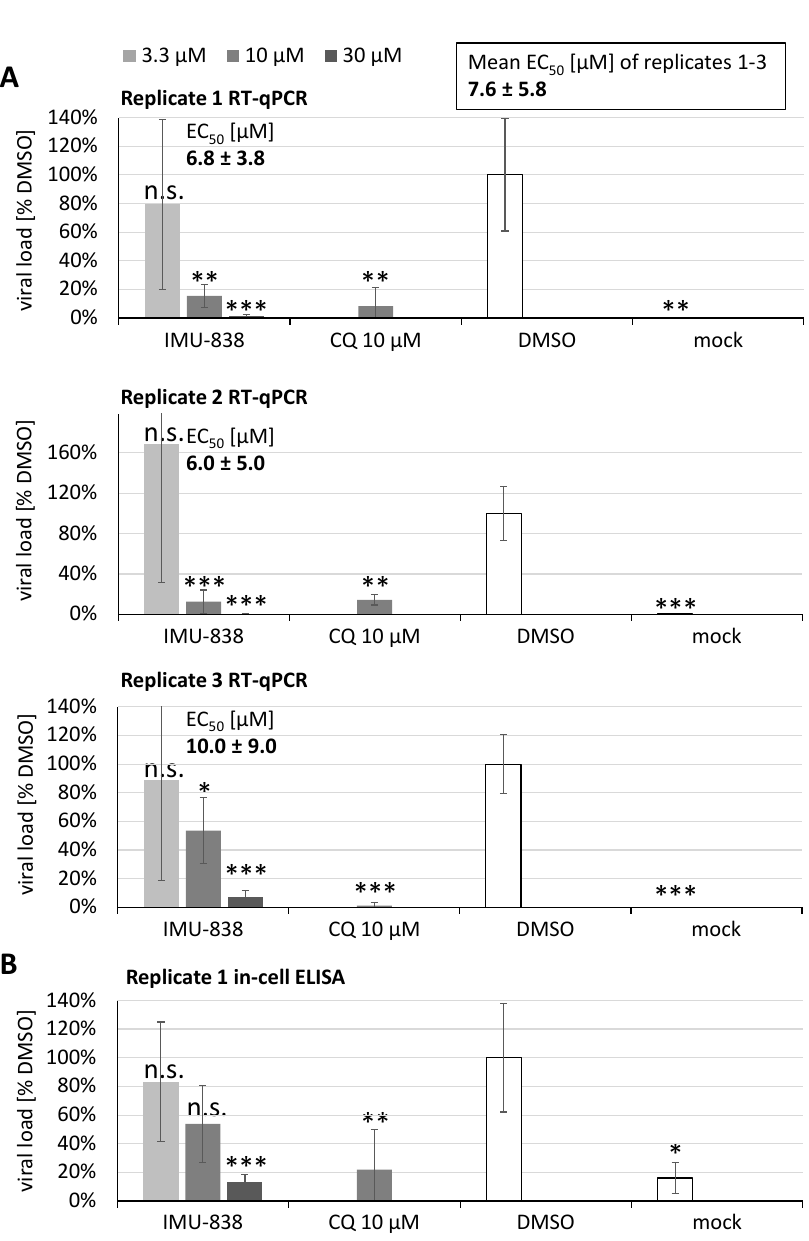
Figure 3. Antiviral activity of IMU-838 determined by RT-qPCR using infectious supernatants of SARS-CoV-2-infected Vero cells, and subsequently by in-cell ELISA using the remaining cell layers. Cells were seeded in 96-well plates one day before infection (4 × 10 4 cells / well), then used for infection with SARS-CoV-2 at a multiplicity of infection (MOI) of 0.0002 and treatment with the concentrations of 30, 10 and 3.3 µM of IMU-838 or 10 µM of chloroquine (CQ) as a control and further cultivated for 2–3 days. Supernatants were harvested, subjected to proteinase K digest for the isolation of viral RNA and used for the determination of extracellular viral load by RT-qPCR. The mean half-maximal effective concentration (EC 50 ) value of the three replicates is given above the panels. ( A ) Replicate 1: SARS-CoV-2 infection/drug treatment of Vero B4 cells measured 2 days post infection (p.i.); replicate